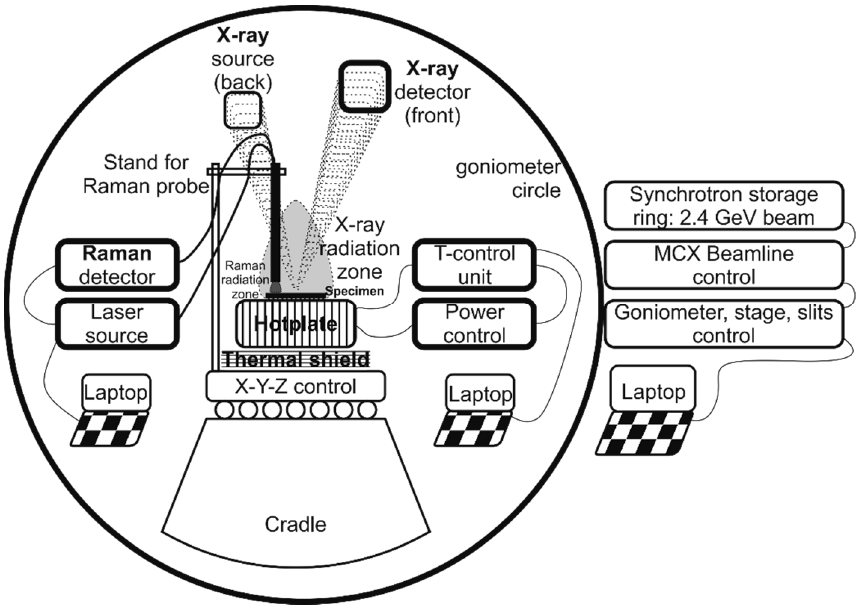
Figure 1. Scheme of the in-operando setup used on the MCX goniometer.